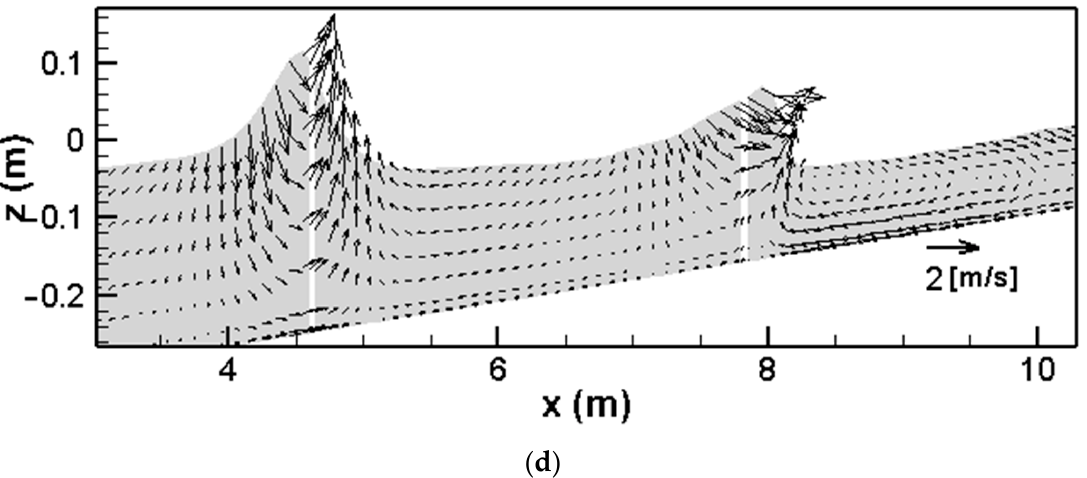
Figure 17. Results 6: instantaneous wave fields in Configuration WKI. ( a ) Turbulent kinetic energy k contour, ( b ) eddy viscosity ν T contour, ( c ) velocity fields (one vector out of every two is shown) and ( d ) zoom of velocity fields at 𝑡 = 98.75 s .